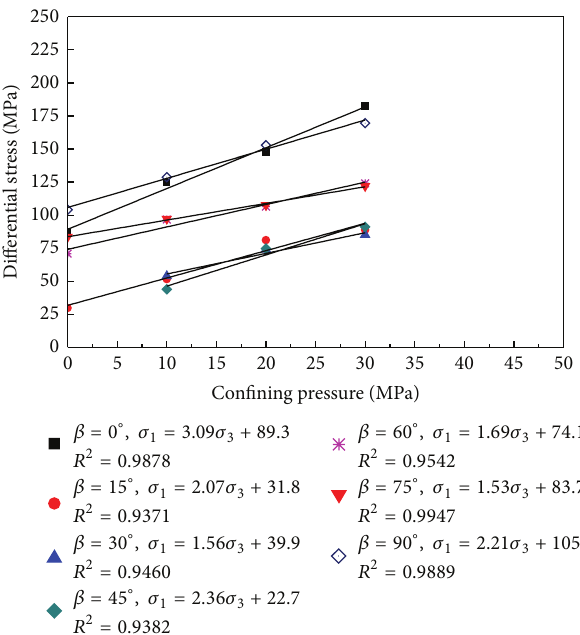
Figure 7: Differential stress at failure ( 𝜎 1 − 𝜎 3 ) versus confining pressure ( 𝜎 3 ) at various orientation angles ( 𝛽